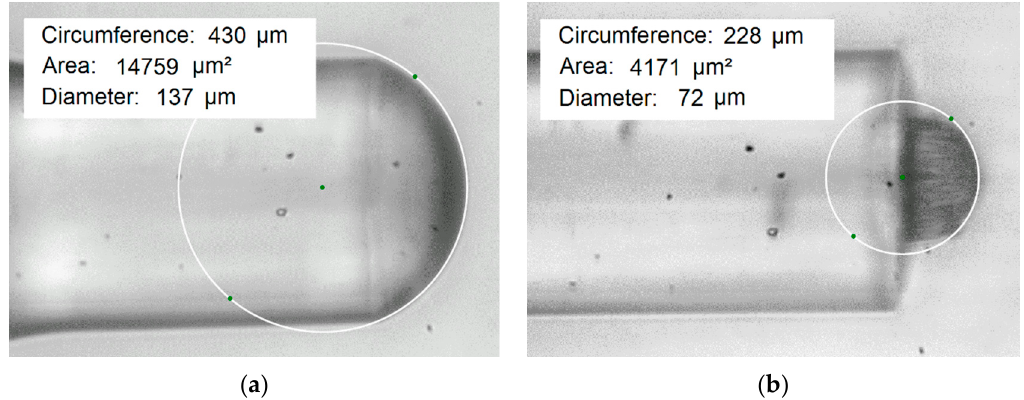
Figure 6. Optical microscope images: ( a ) a drop of liquid polymer; ( b ) microtip cured by using a VIS laser with P = 5 µ W and t = 20 s.